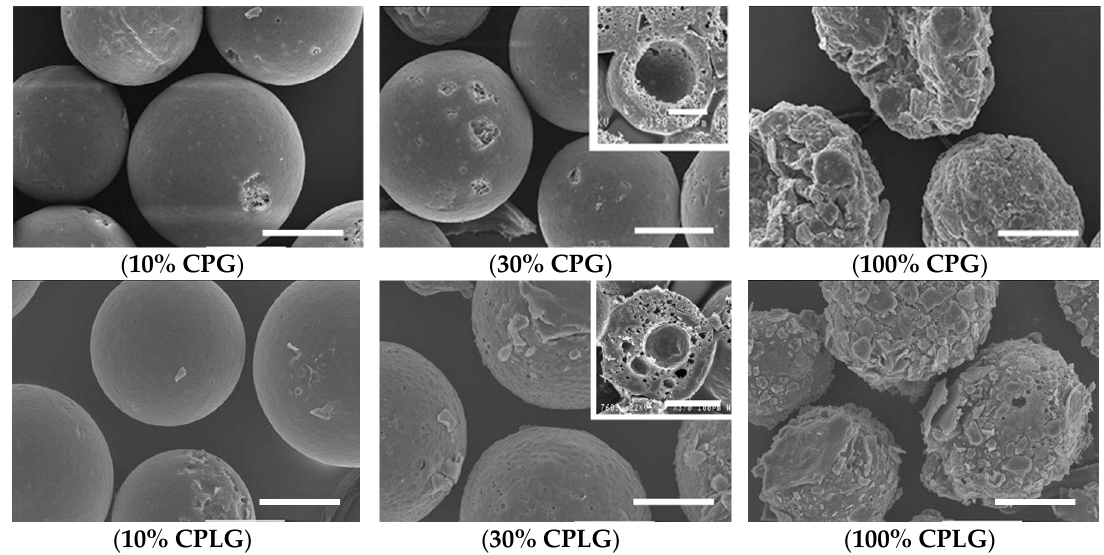
Figure 4. SEM micrographies of microparticles obtained by modifying the composition of the copolymer and its relative content in the oil phase of the o / w dispersion. The wt. % refers to the copolymer content to the total material in oil phase. Scale bars: 100 µ m.